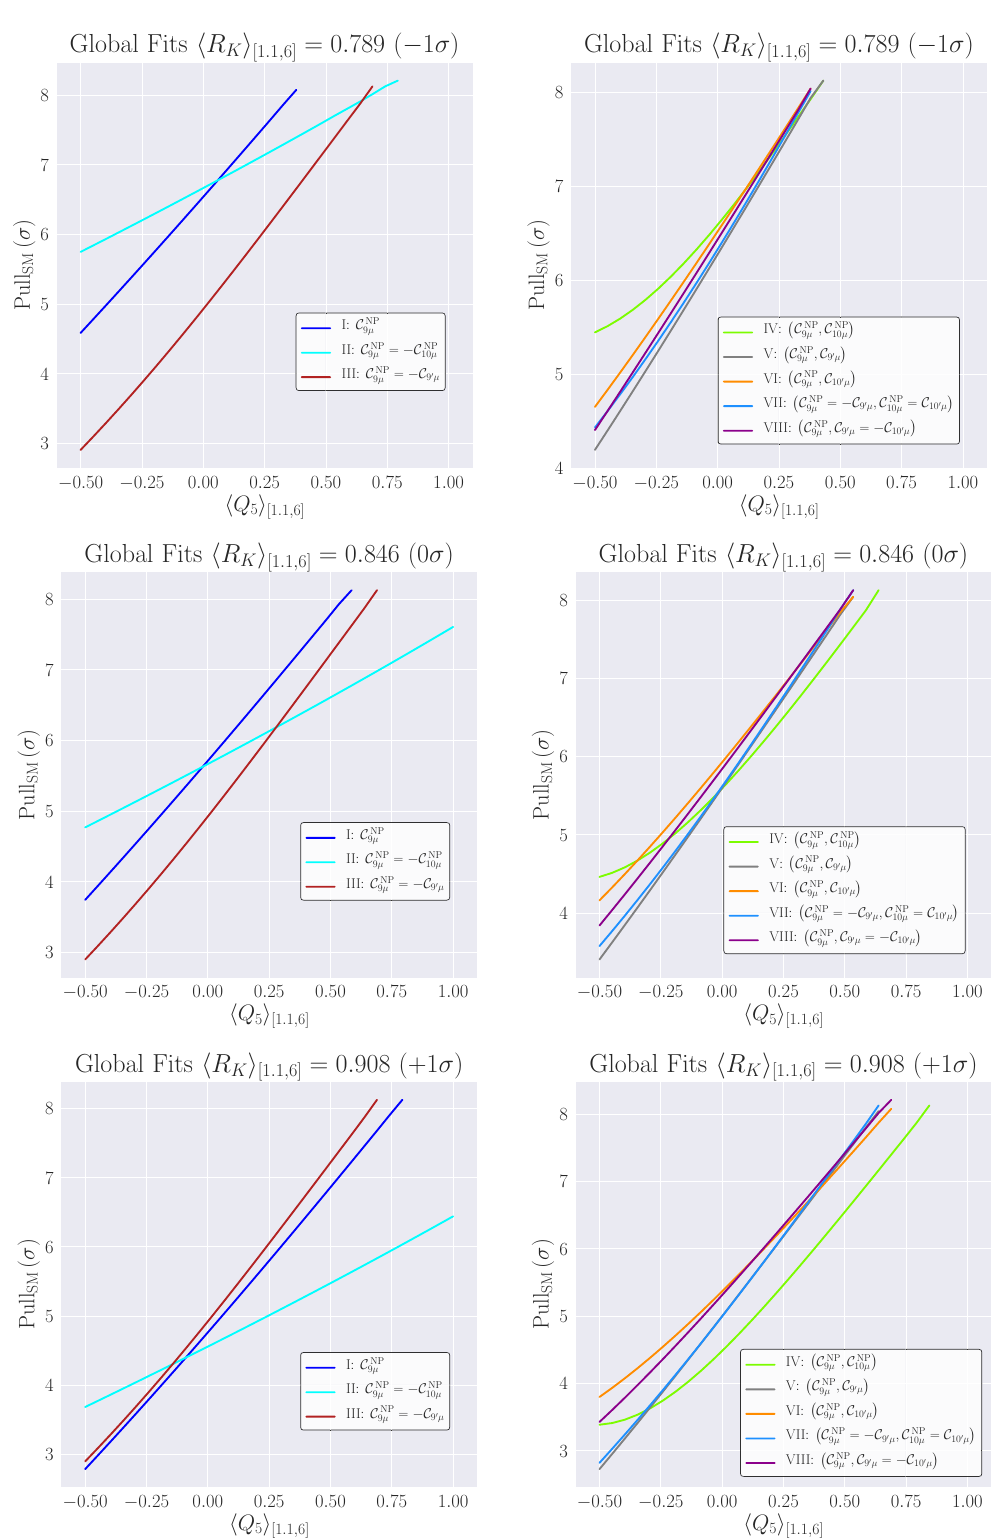
on the Pull SM of the NP scenarios under consideration Q 5 (cid:31) (cid:30) [1 . 1 , 6] R K (cid:30) [1 . 1 , 6] (cid:31)